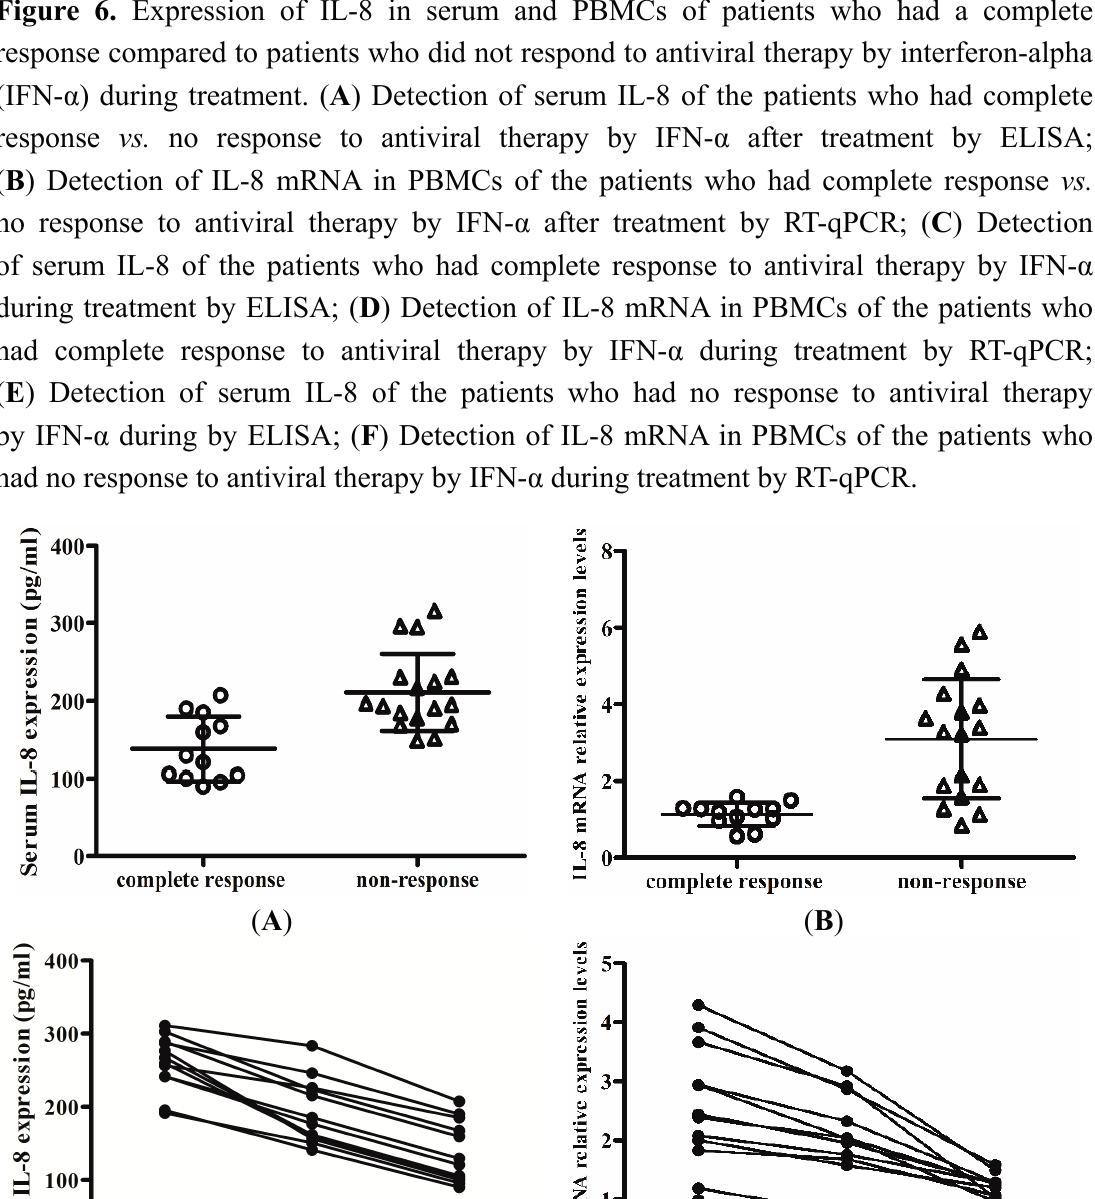
2.5. Levels of IL-8 in Serum and the Peripheral Blood Mononuclear Cells (PBMCs) Responses to Interferon-Alpha (IFN- α ) Therapy After treatment with IFN- α , the results of ELISA and RT-qPCR showed that CHB patients with a complete response to antiviral therapy by IFN- α had a lower expression of IL-8 in the serum and PBMCs. Meanwhile, the expression levels of IL-8 in the serum and PBMCs of CHB patients without response to IFN- α were significantly higher (138.076 ± 41.665 vs. 211.039 ± 50.016, t = 4.271,